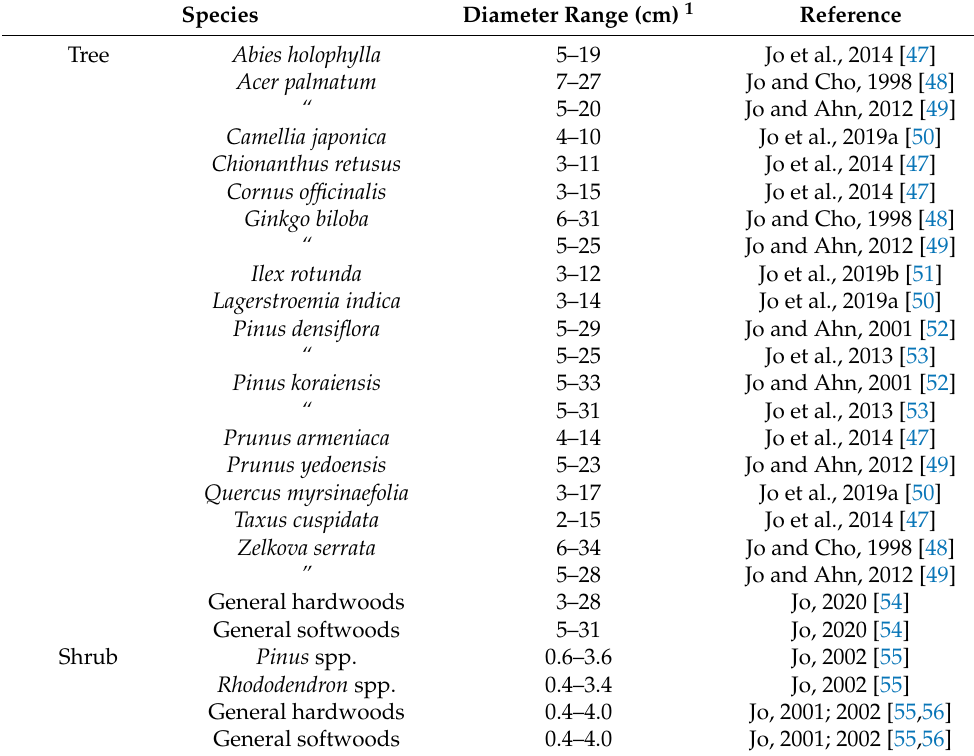
Table 2. Quantitative model sources used to calculate carbon uptake of landscape